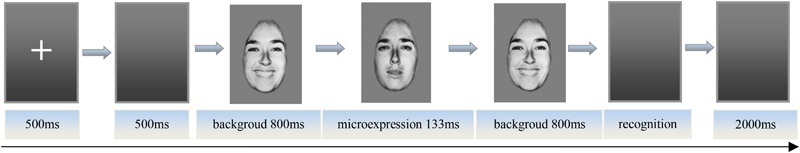
The picture of experiment procedure.